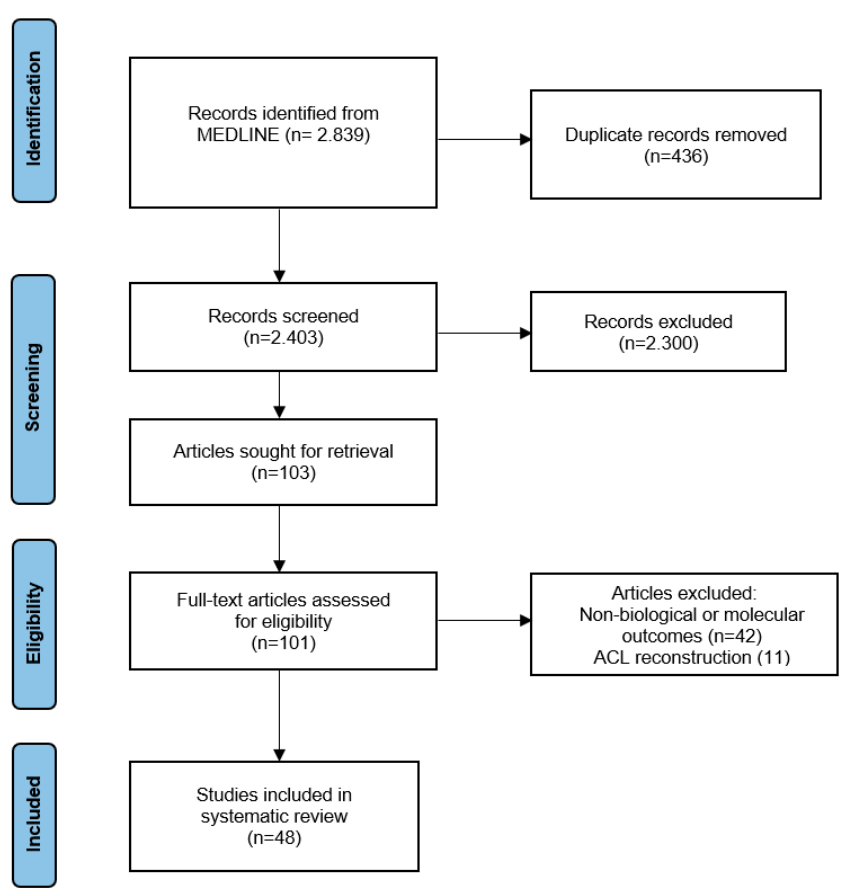
Figure 1. Flow chart diagram for inclusion and exclusion article process.